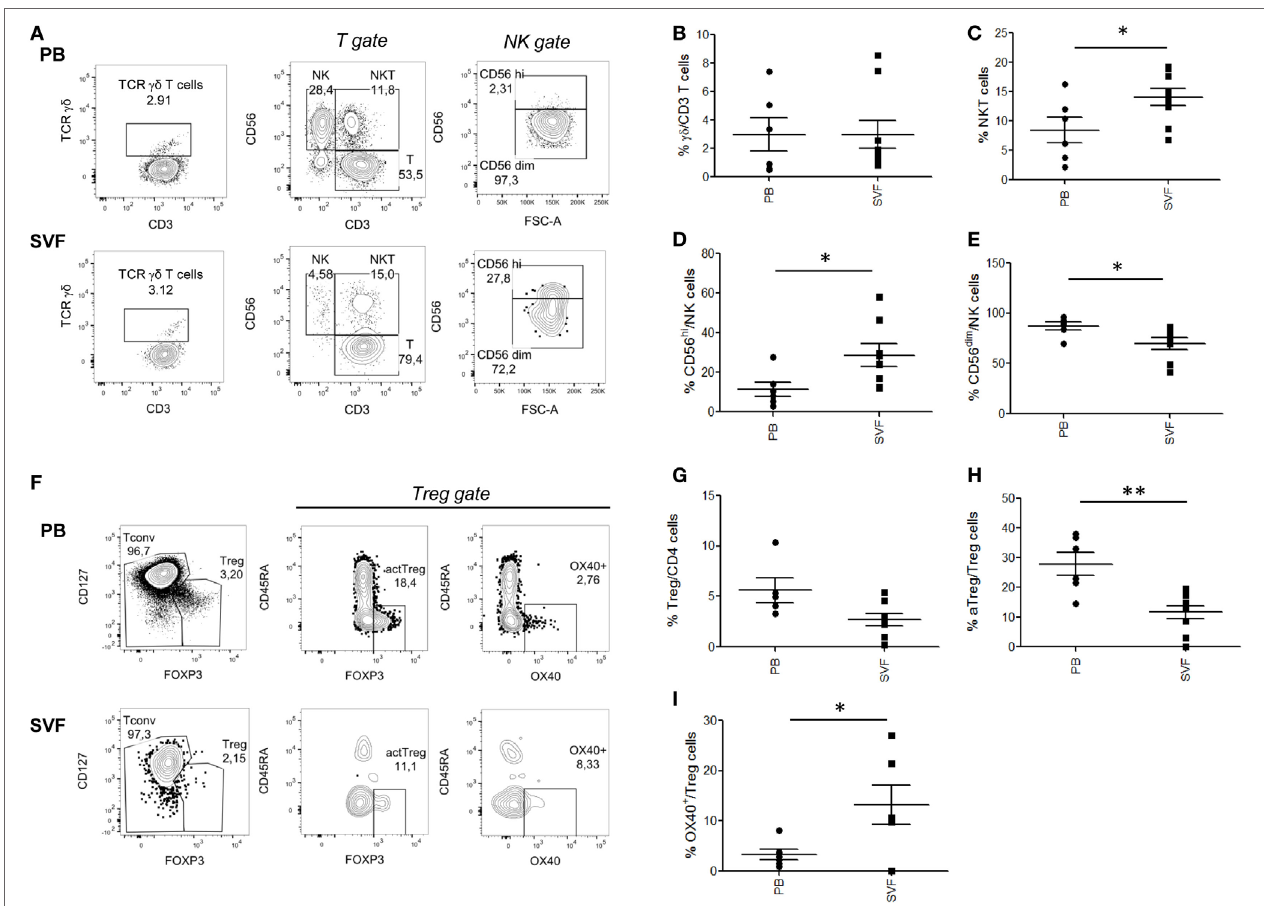
FigUre 1 | Composition of major T lymphocyte subpopulations in visceral adipose tissue (VAT) stromal vascular fraction (SVF) versus peripheral blood (PB) of lean healthy subjects. Cell subset percentages within total PB and VAT SVF lymphocytes of nine healthy lean subjects were analyzed. Gating strategies for NK, NKT, T, and γδ T cells (a) , total regulatory T (T reg ), conventional T cells (T conv ), OX40 + T reg and activated T reg cells (aT reg ) (F) , in PB and SVF from a representative donor. γδ T cells,